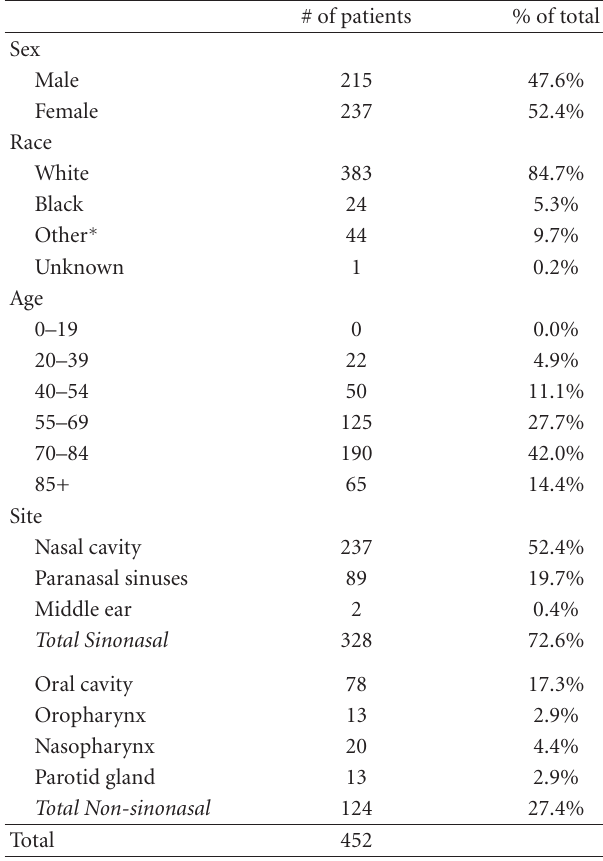
Table 1: Characteristics of patients with mucosal melanoma of the head and neck identified in SEER 9 from 1987 to